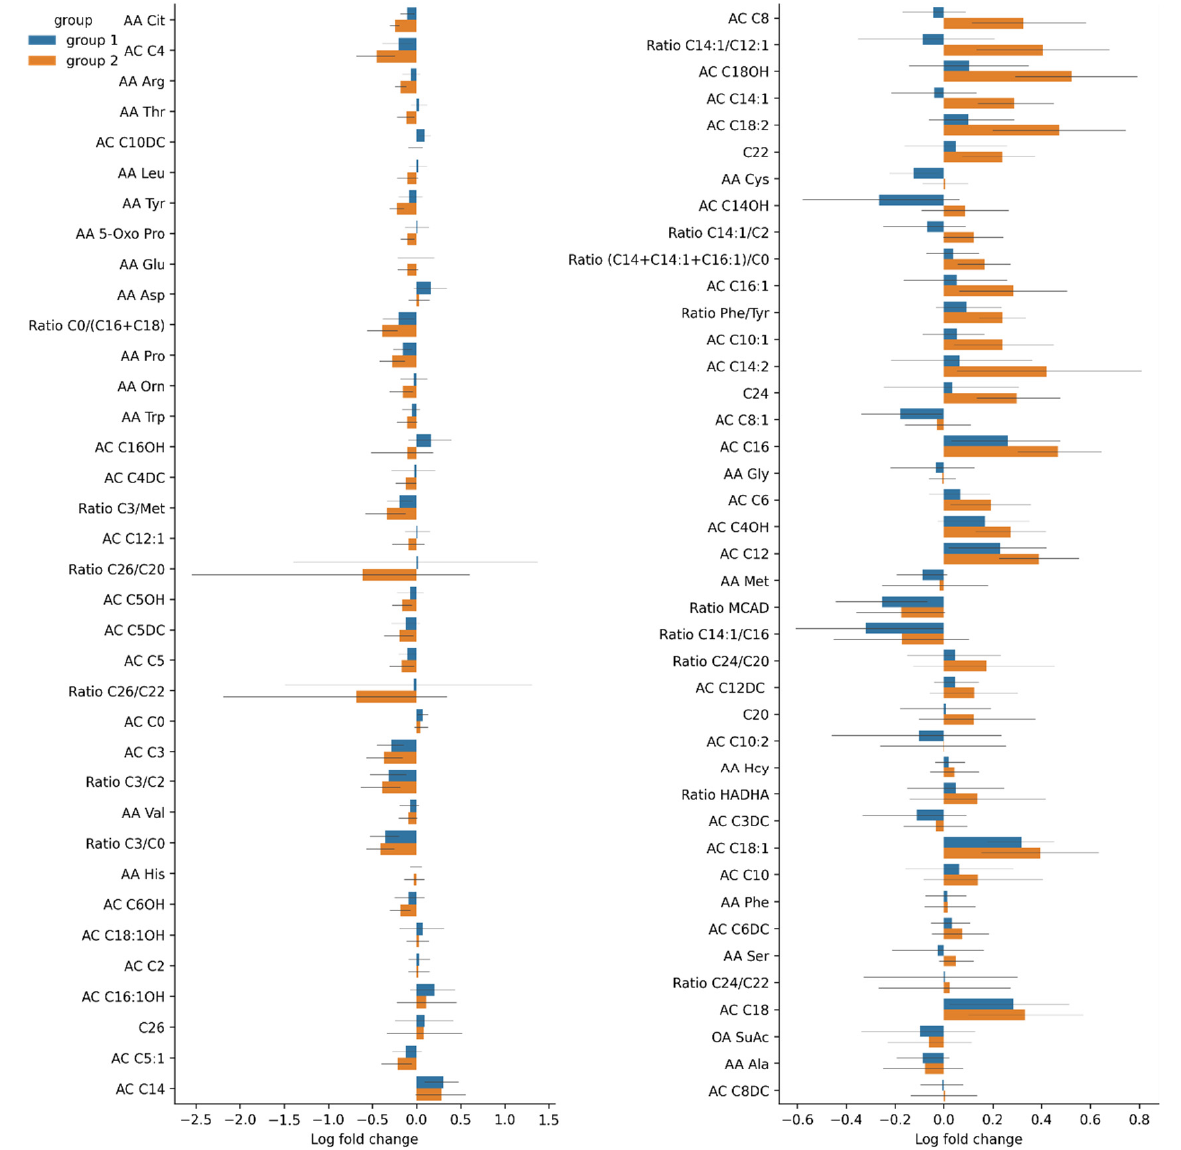
Figure 13. Fold changes in pre-TBI (day 0) amino acid levels in Groups 1 and 2. Significant results are presented in red.